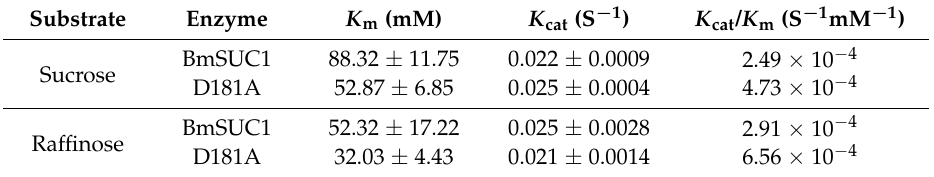
Table 3. Kinetic parameters of BmSUC1 and D181A on different